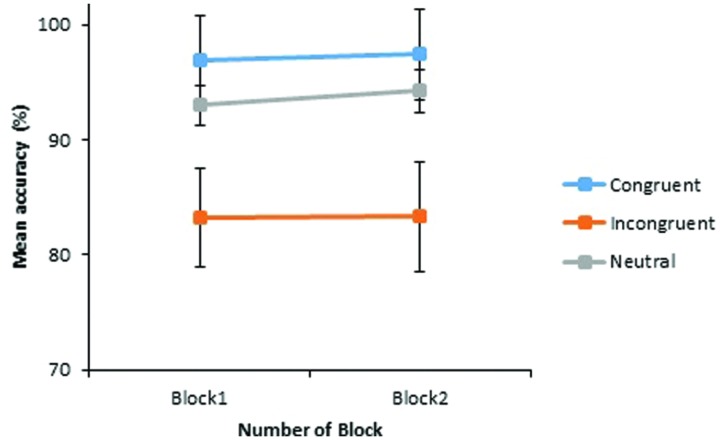
Experiment 2: mean percentages of correct judgments to critical word pairs in Block 1 and Block 2. The vertical axis begins at 70% while error bars indicate the 95% confidence interval.